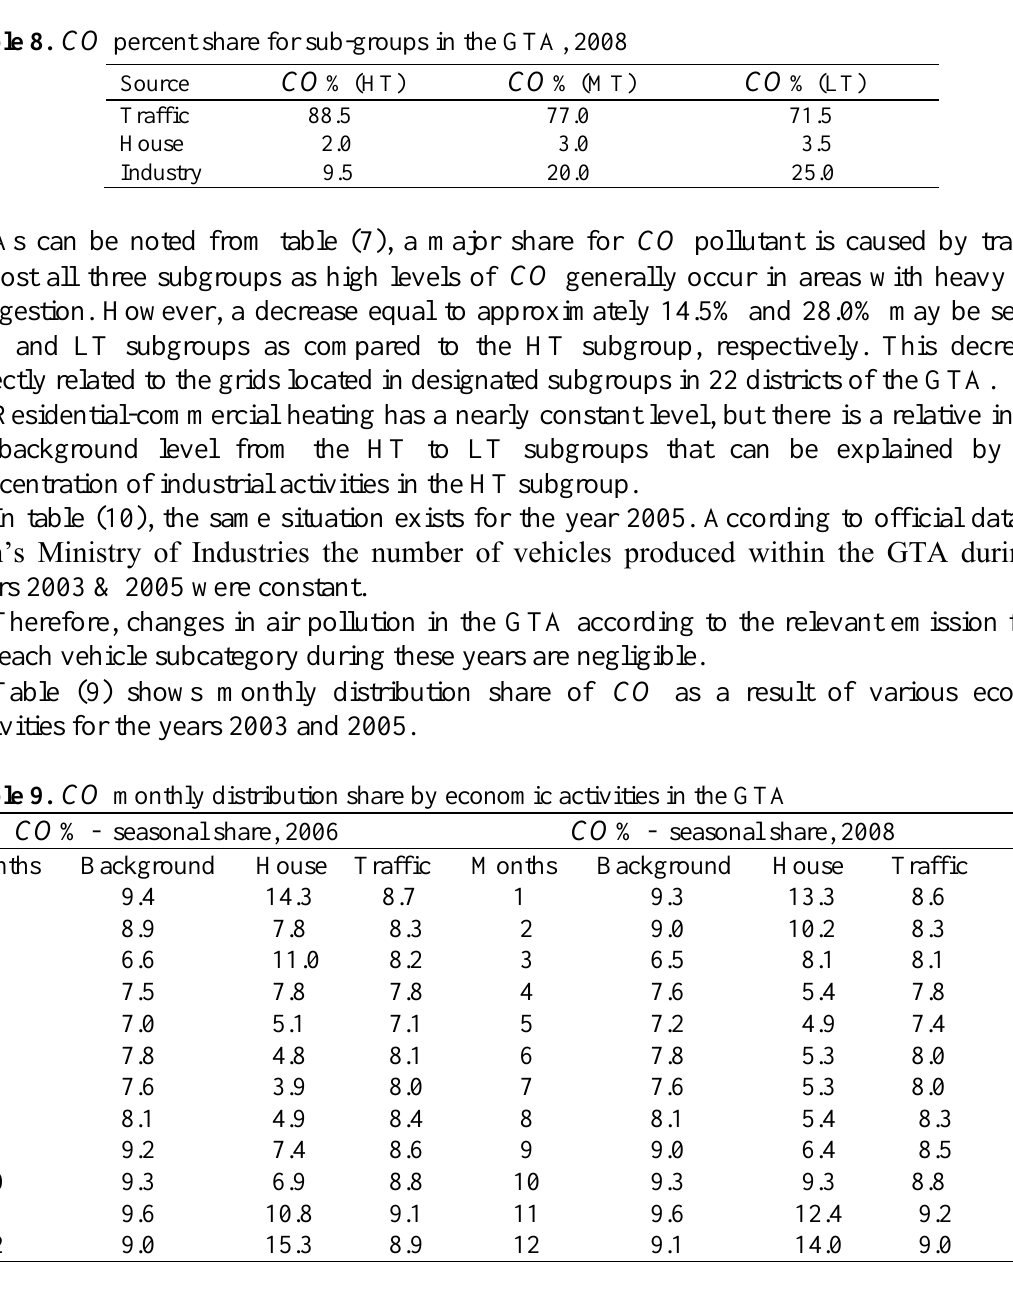
Table 7. C O percent share for sub-groups in the GTA, 2006 Source Traffic